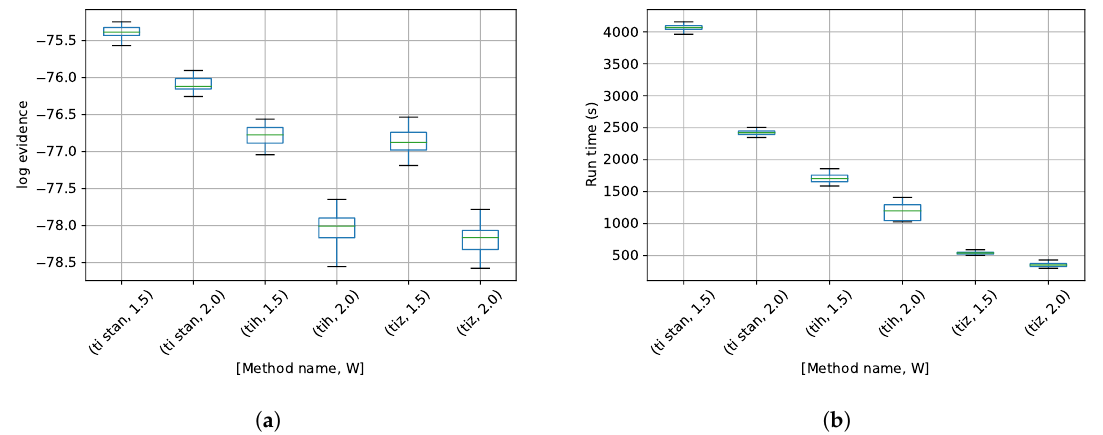
Figure 4. MSF model with J = 1 results. ( a ) Box-plot of log-evidence for the three stationary frequency model for TI-Stan, TI-BSS-H, and TI-BSS-Z, for two values of W ; ( b ) Box-plot of run time for the three stationary frequency model for TI-Stan, TI-BSS-H, and TI-BSS-Z, for two values of W